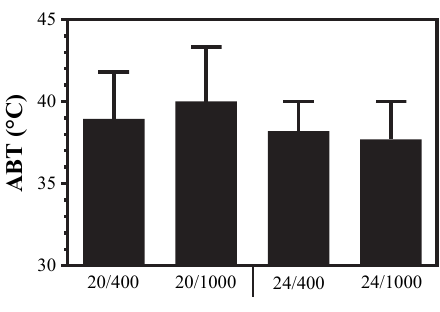
Figure A4. Arrhenius breakpoint temperature (ABT) of heart rate of limpets acclimated at different temperatures (20 or 24 ◦ C) and CO 2 concentrations (400 or 1000ppm). After acclimation in dif- ferent conditions, limpets were heated continuously from acclima- tion temperatures until the heart stopped beating. During the heating process, heart rates were recorded and ABTs were